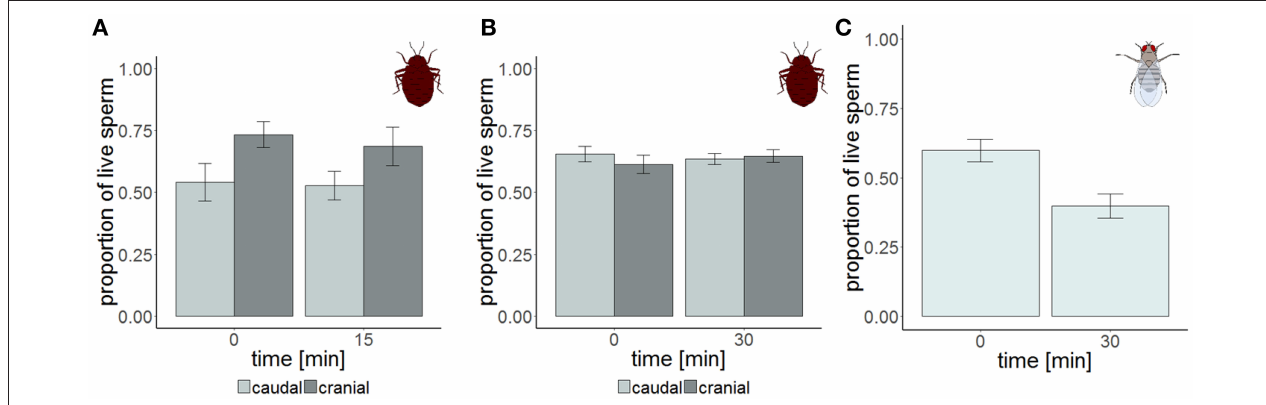
FIGURE 2 | Sperm viability in the cranial (dark gray) and the caudal (light gray) part of the seminal vesicle of Cimex lectularius at two different points in time. The samples were measured either non-blind ( A , n = 14) and supported the hypothesis that sperm should have higher viability at the cranial site, or were blind ( B , n = 15). Sperm viability in the seminal vesicle of Drosophila melanogaster ( C , n = 15). Bars show mean ± s.e.